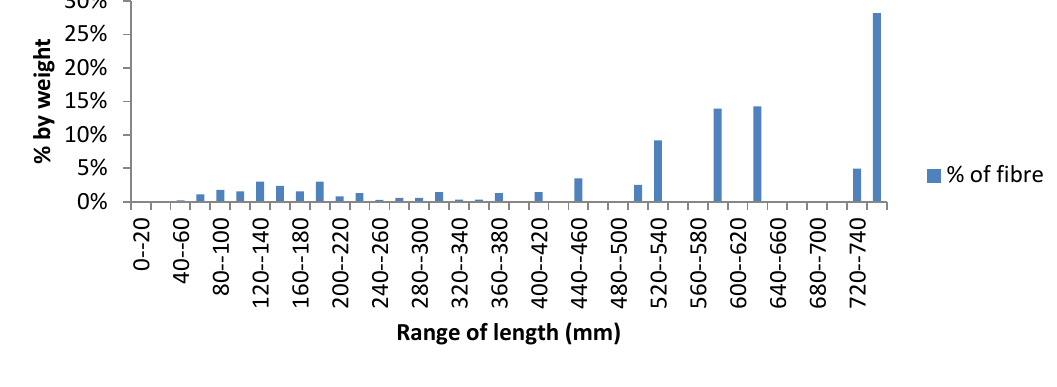
Figure 7. Percentage of lengths by weight–retted flax fiber